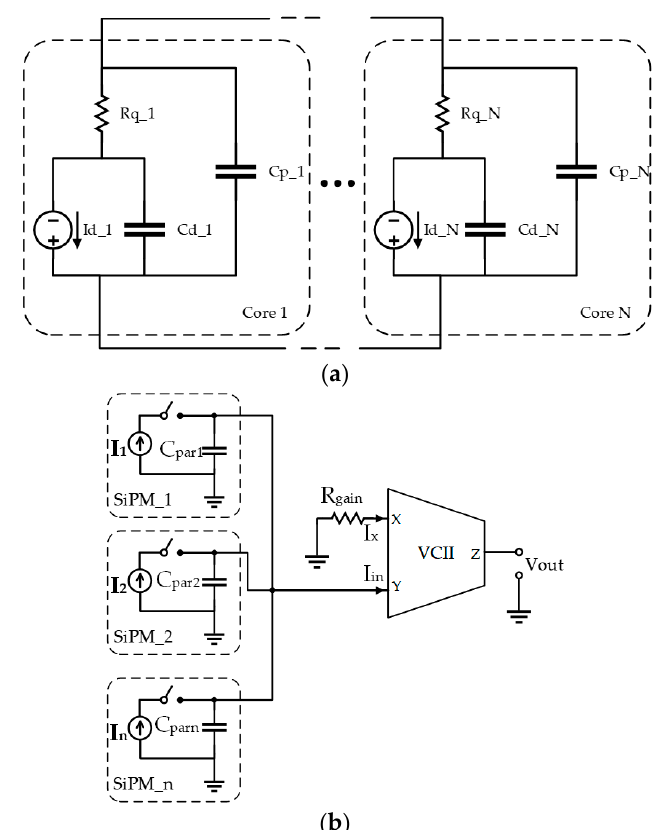
Figure 5. ( a ) Silicon photomultipliers (SiPM) equivalent model; ( b ) the proposed VCII-based SiPM array interface where C par_i = Σ C p_N .